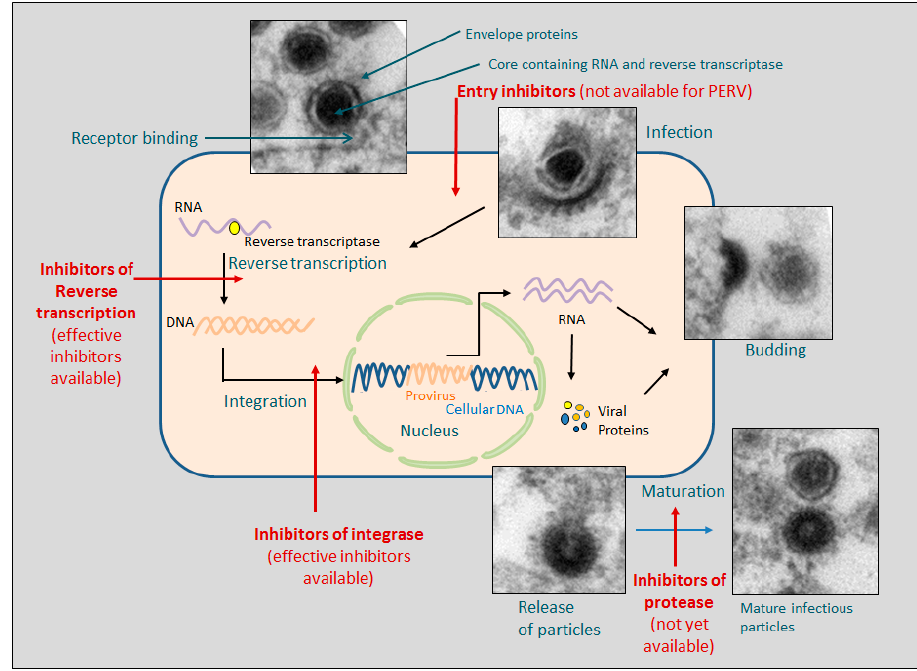
Figure 1. Life cycle of PERV and targets of four groups of antiretroviral drugs. It is indicated whether these inhibitors are available for treatment of PERV infection in vitro. The electron microscopic pictures show infection of human 293 cells by PERV and release of virus